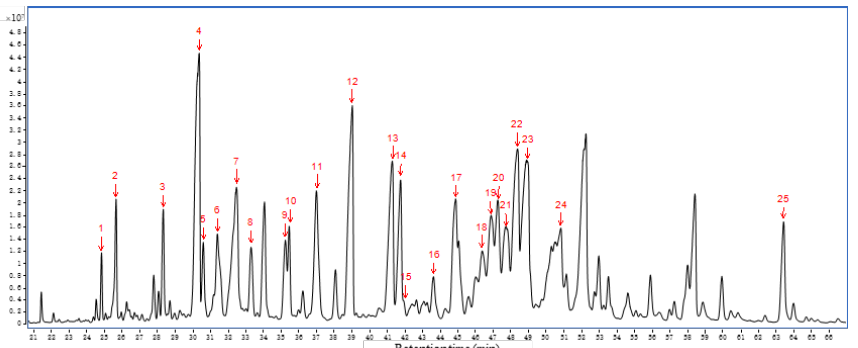
Figure 5. GC-MS chromatograms of HS-SPME extracts for AEO sample.